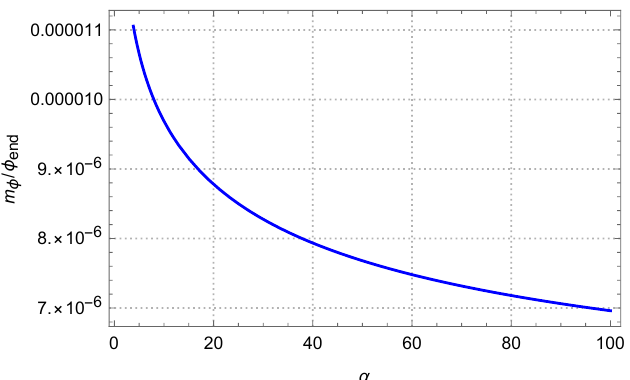
Figure 5. (cid:11) dependence of the ratio between m (cid:30) and (cid:30) end obtained from eq. (2.33) and eq. (2.25). We have chosen n = 1 and n s = 0 : 9645 as a pivot